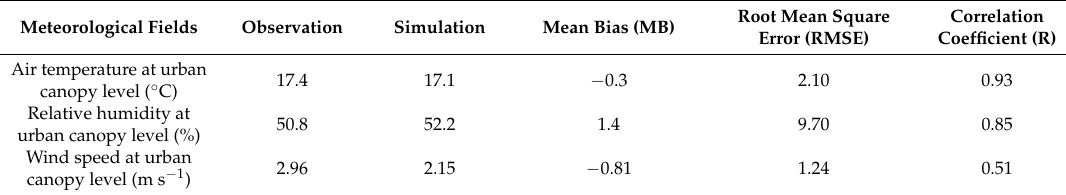
Table 1. Comparisons of simulated air temperature, relative humidity, and wind speed at the urban canopy level with observations in 2007 and 2008.